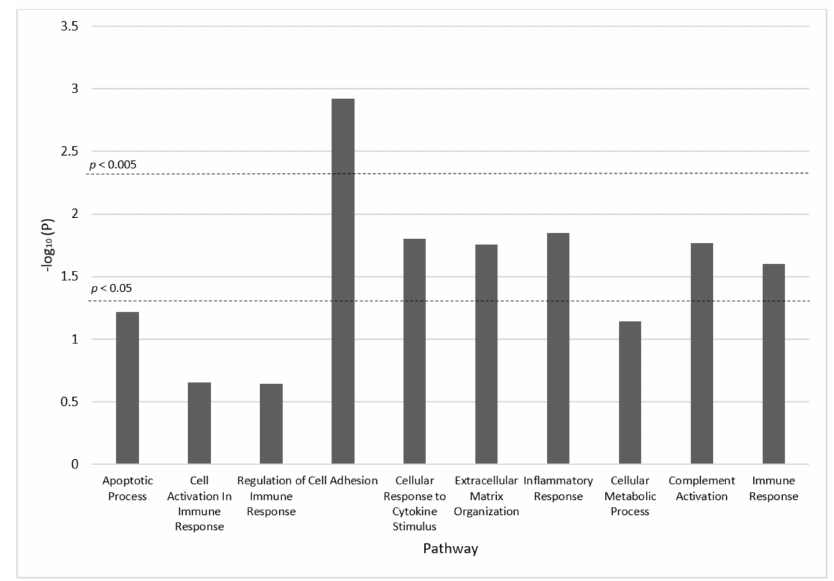
Figure 3. Pathway analysis